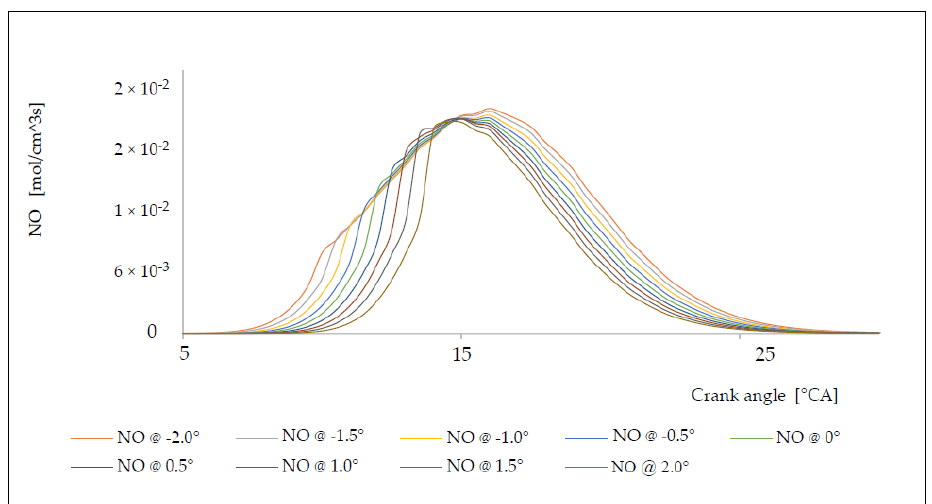
Figure 10. Dependence of NO concentration on the change in injection timing at 50% MCR [22].